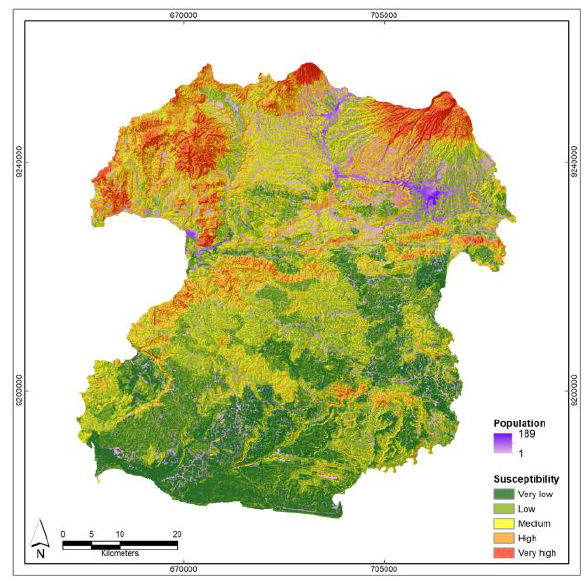
Figure 9. Level of population exposure to landslide risk in relation to population density in